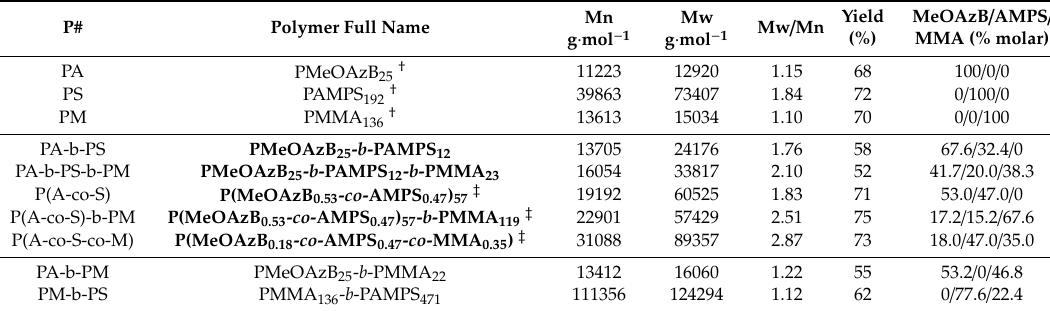
Macro CTAs. ‡ molar percentages were determined from 1